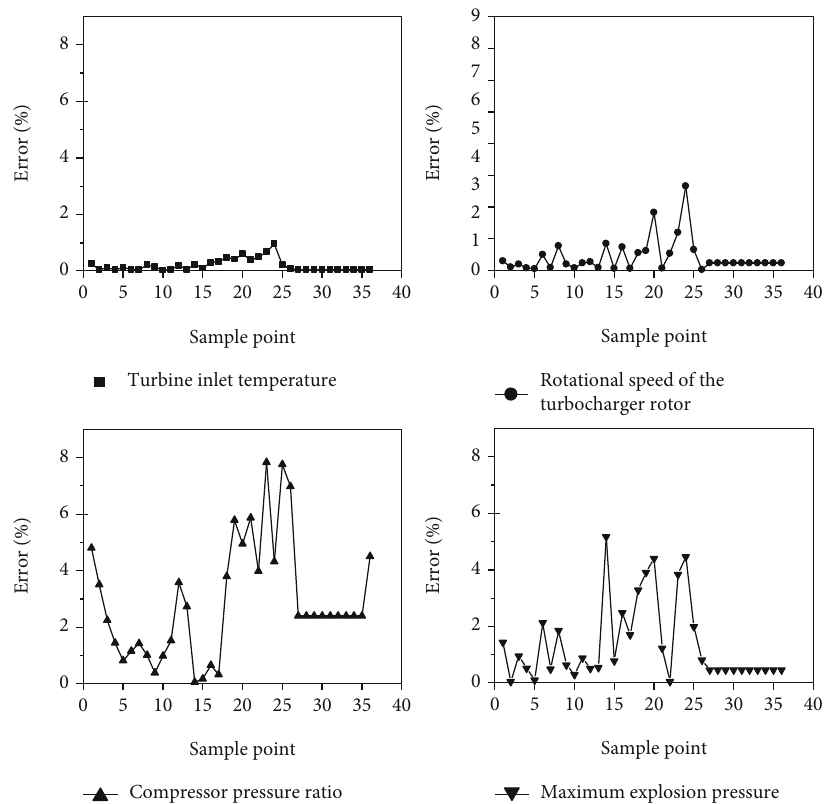
Figure 10: Relative errors between the data from the surrogate model and the simulation model for the work boundaries.